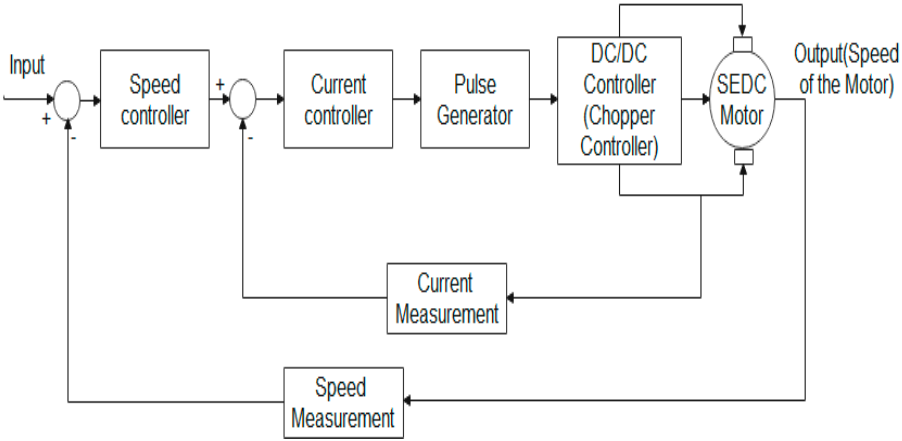
Figure 2. Double feedback control system of SEDC motors.